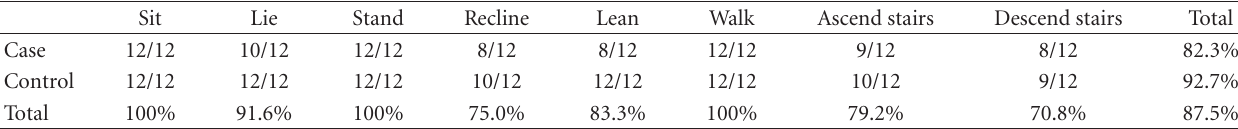
Table 3: The accuracy of activity type detection by the IDEEA monitor.